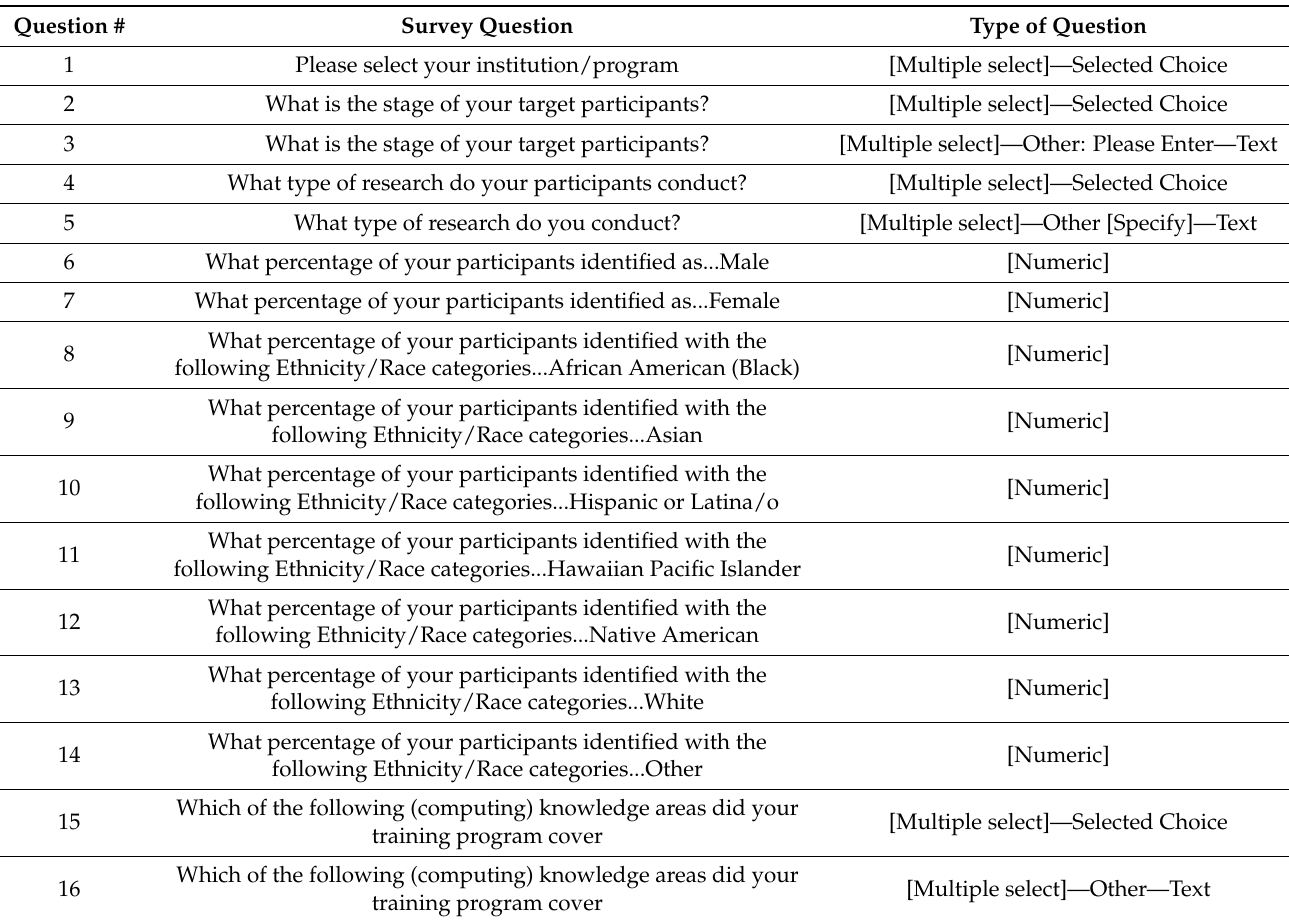
Table A1. Survey Questions Administered to Program Coordinators at Participating RCMI